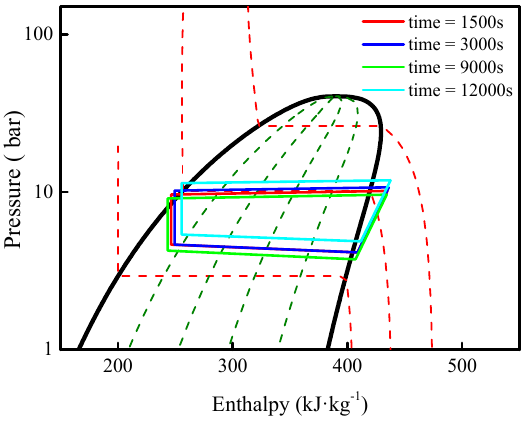
Figure 16. p-h diagrams of VCR in thermal management in a cold day.